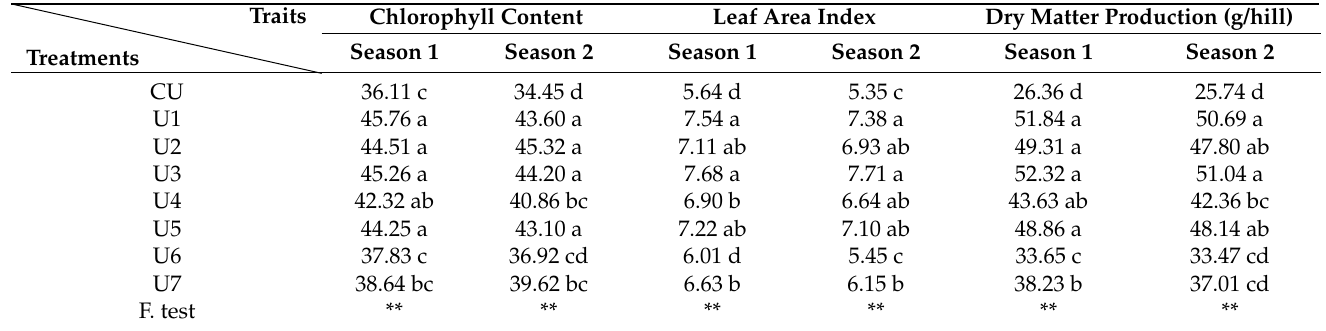
Table 4. Effects of different rates of classical urea fertilizer, urea chitosan nanohybrid, and their combinations as an exogenous application on chlorophyll content, leaf area index, and dry matter production of rice plants during the 2020 and 2021